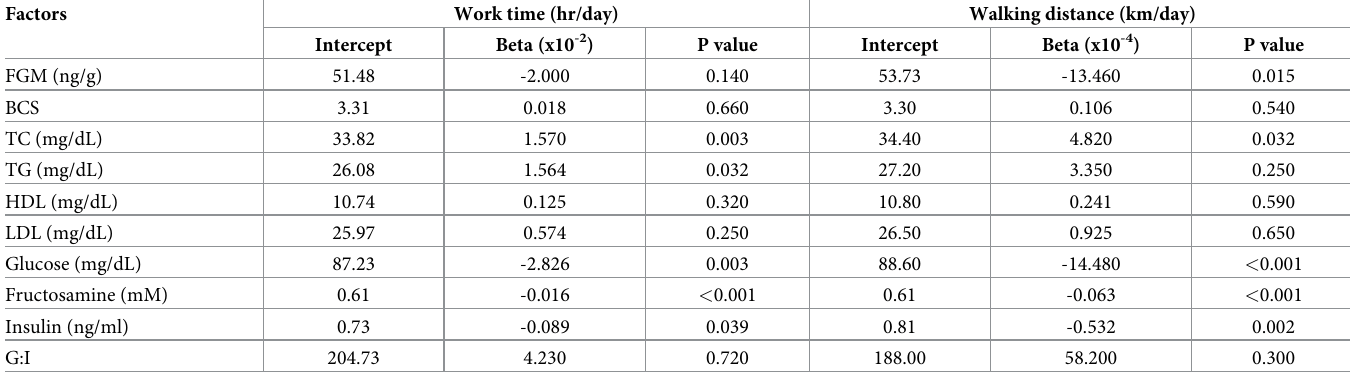
FGM = fecal glucocorticoid metabolites; BCS = body condition score; TC = total cholesterol; TG = triglycerides; HDL = high density lipoproteins; LDL = low density lipoproteins; G:I = glucose to insulin ratio.